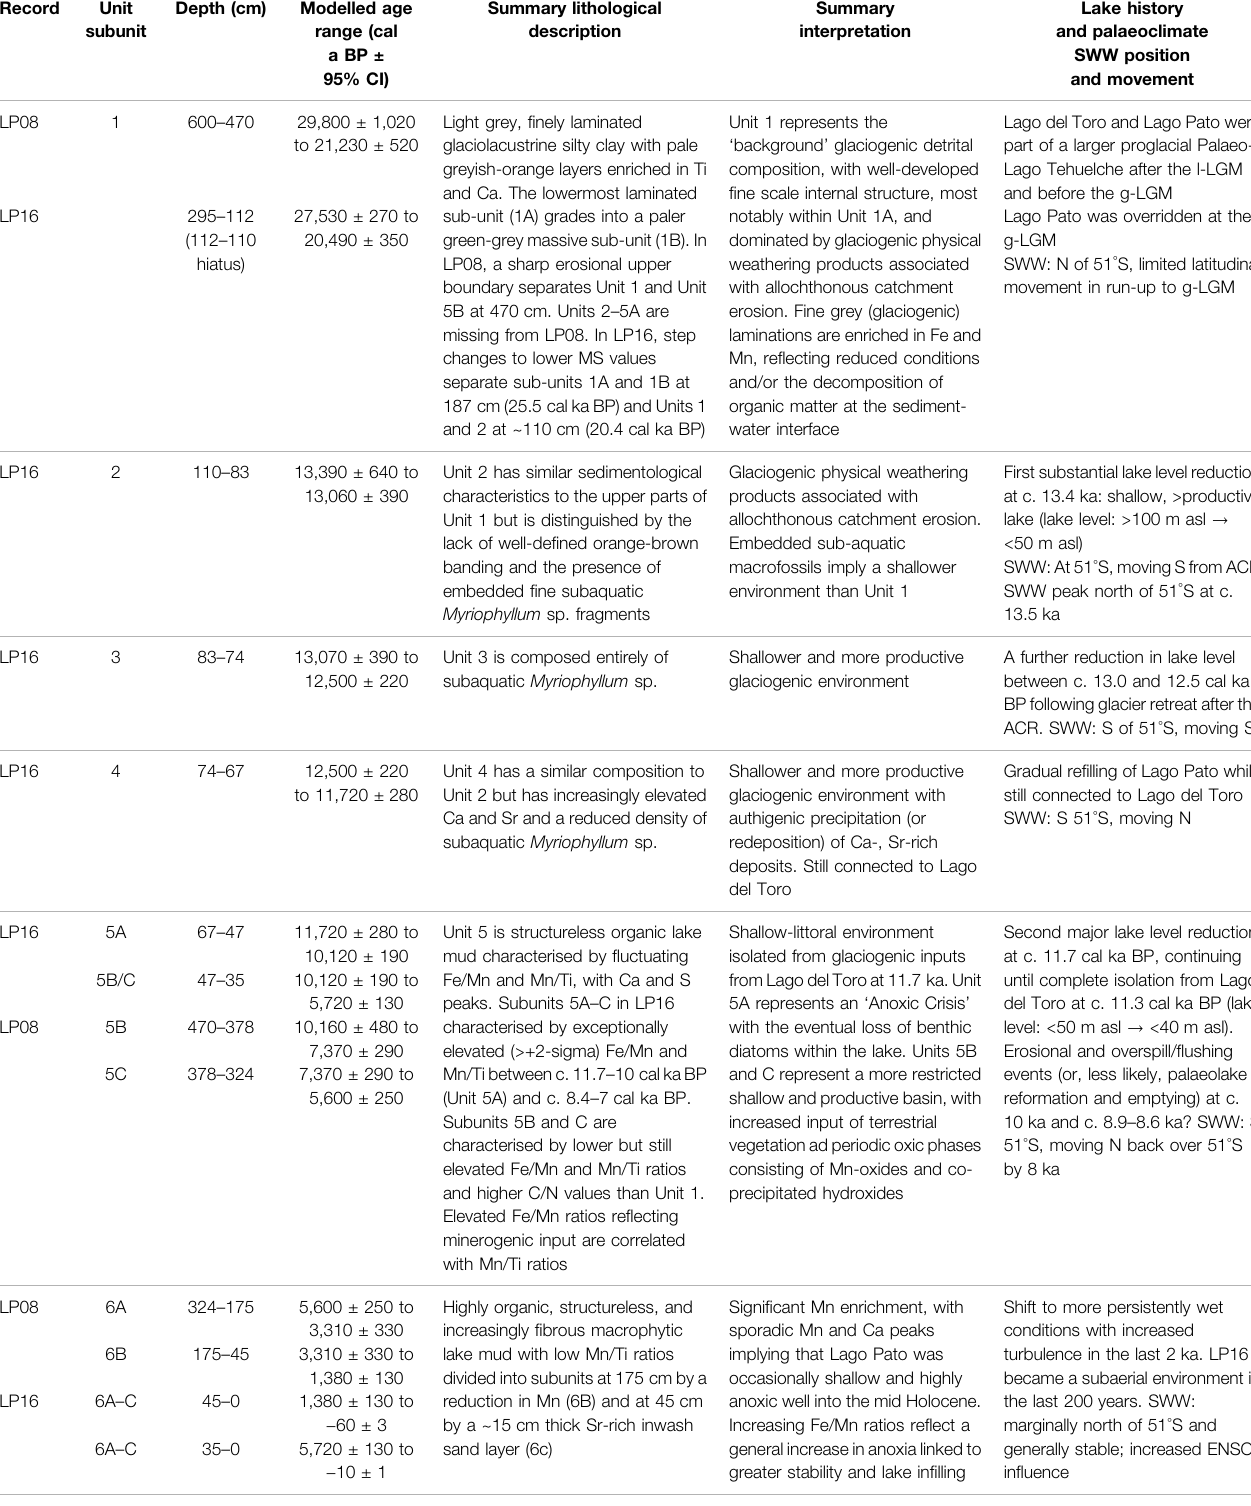
TABLE 2 | Summary descriptions and interpretations of the lithofacies units in the Lago Pato LP08 and LP16